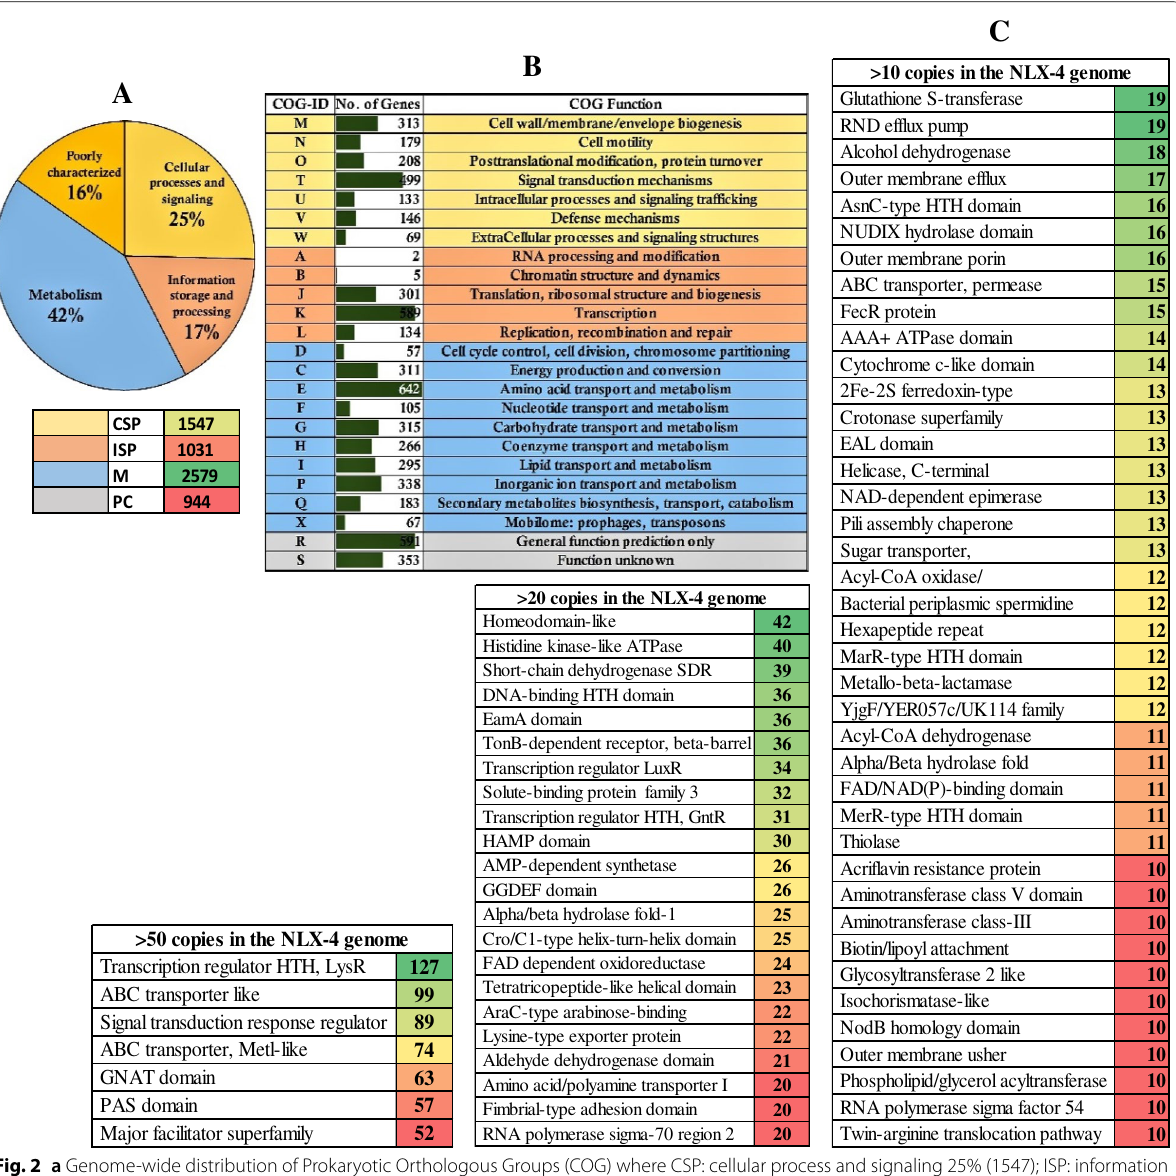
and 3897 (62.46%) Swiss-Prot, respectively (Additional file 1: Table S5f). The COG has classified the protein encoding genes into 25%-cellular signaling and pro- cessing, 17%-information storage and processing, 42%-metabolism and 16%-poorly characterized, respec- tively (Fig. 2). The GO has classified protein coding genes into 55%-biological process, 16%-cellular process and 29%-molecular function, respectively (Fig. 3). The